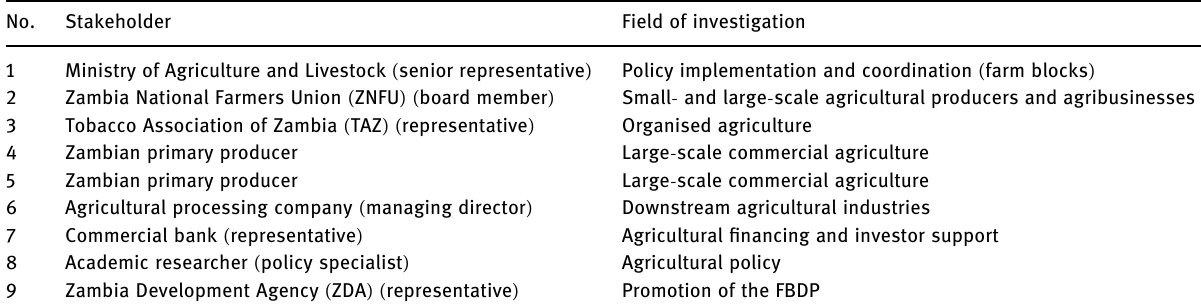
Table 2: Stakeholder groups included in the semi - structured interviews